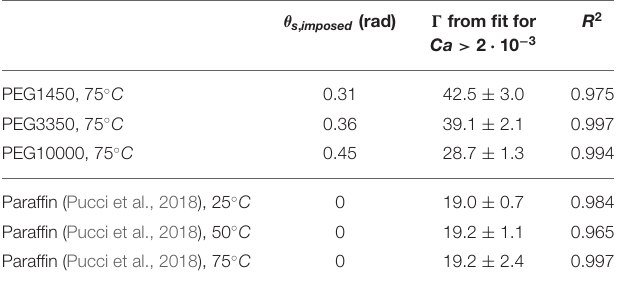
TABLE 4 | Obtained parameters from HDT fit at high Ca for partially and totally wetting